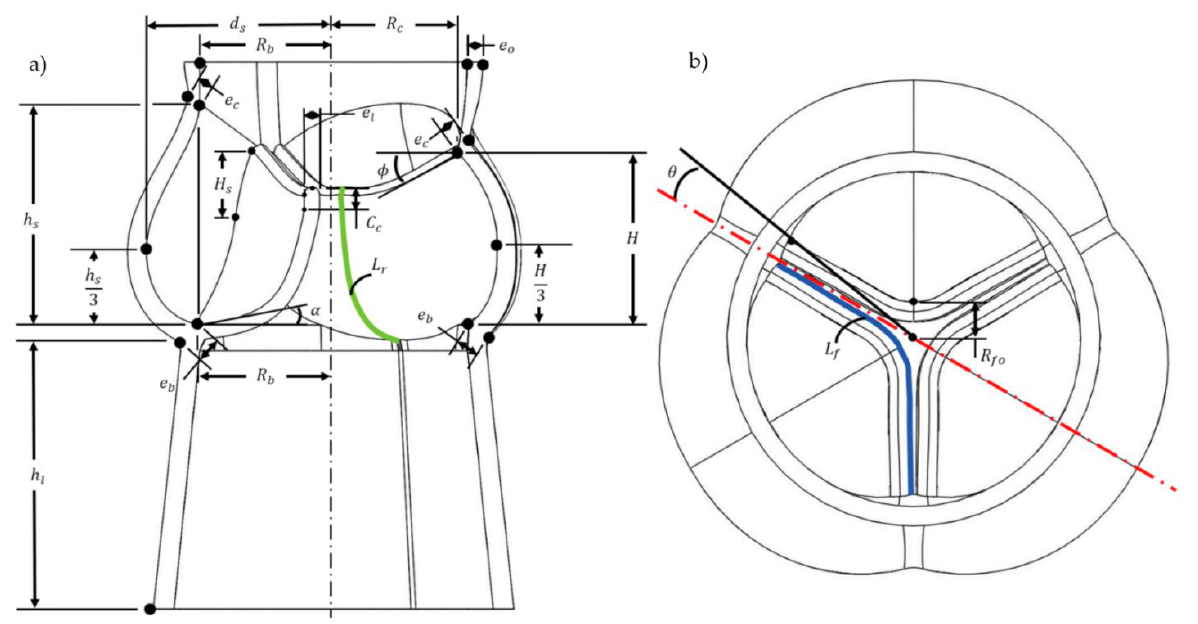
Figure 5. Geometry and parameters of the aortic valve scaffold model. ( a ) Inner section. ( b ) Top view.